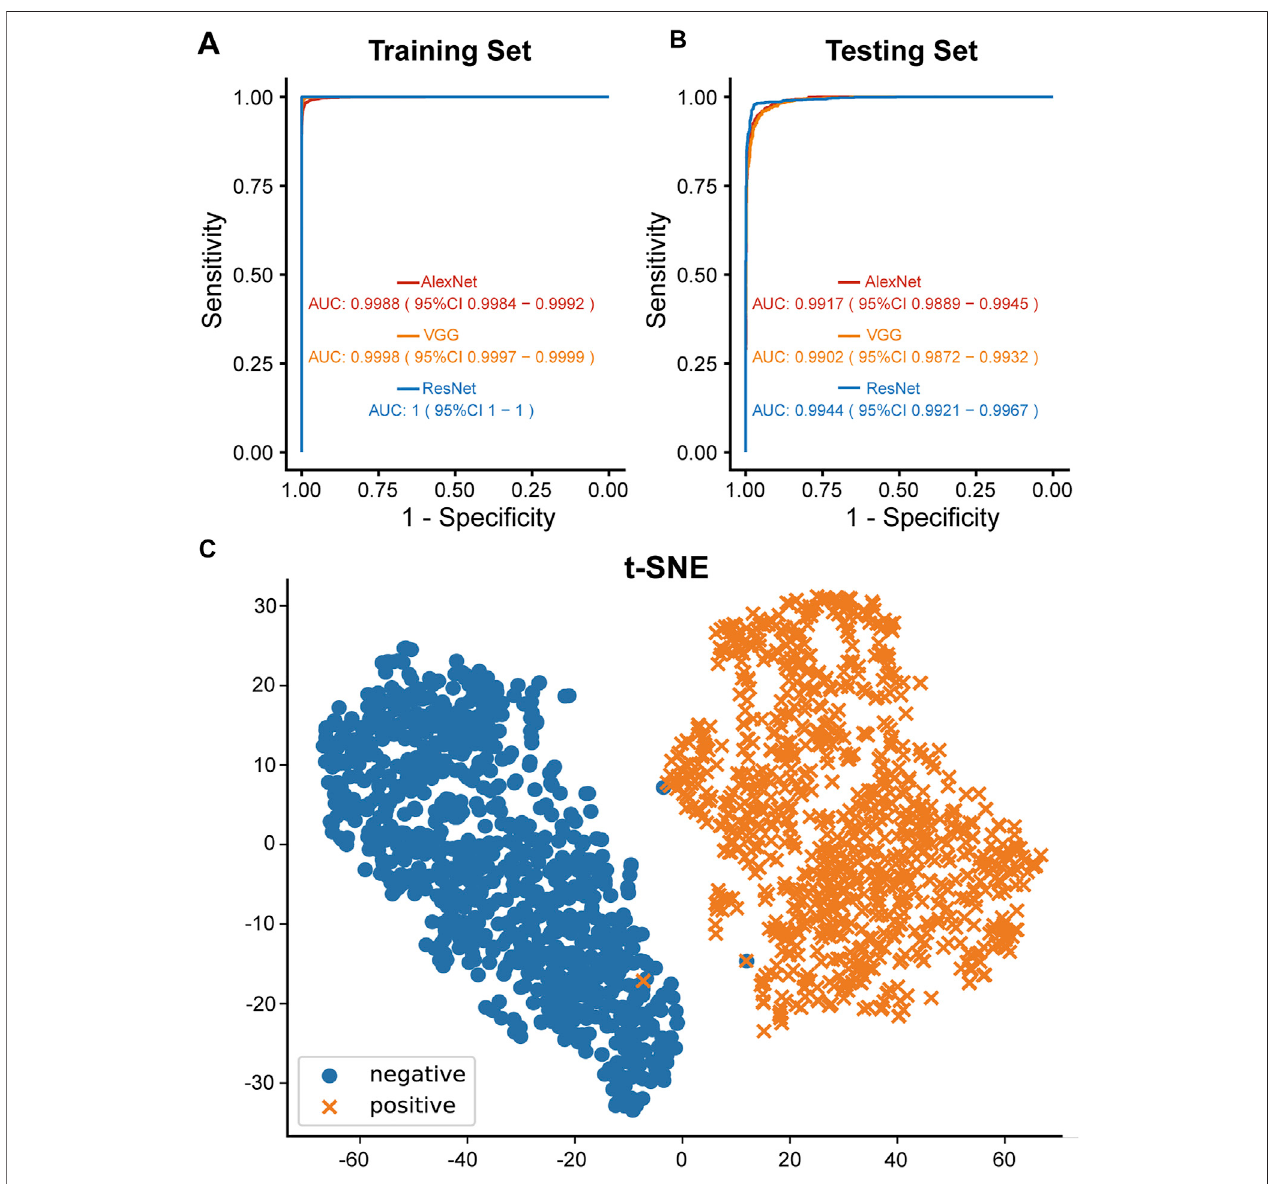
FIGURE 3 | Diagnostic ability of the AI models. (A) ROC curves of three different AI models of the training set. (B) ROC curves of three different AI models of the testingset. (C) DiagnosticabilityofResNetalgorithmvisualizedbyt-SNEalgorithm.BlueandorangedotsindicatedTBandnon-TBcasesofthetestingset,respectively.